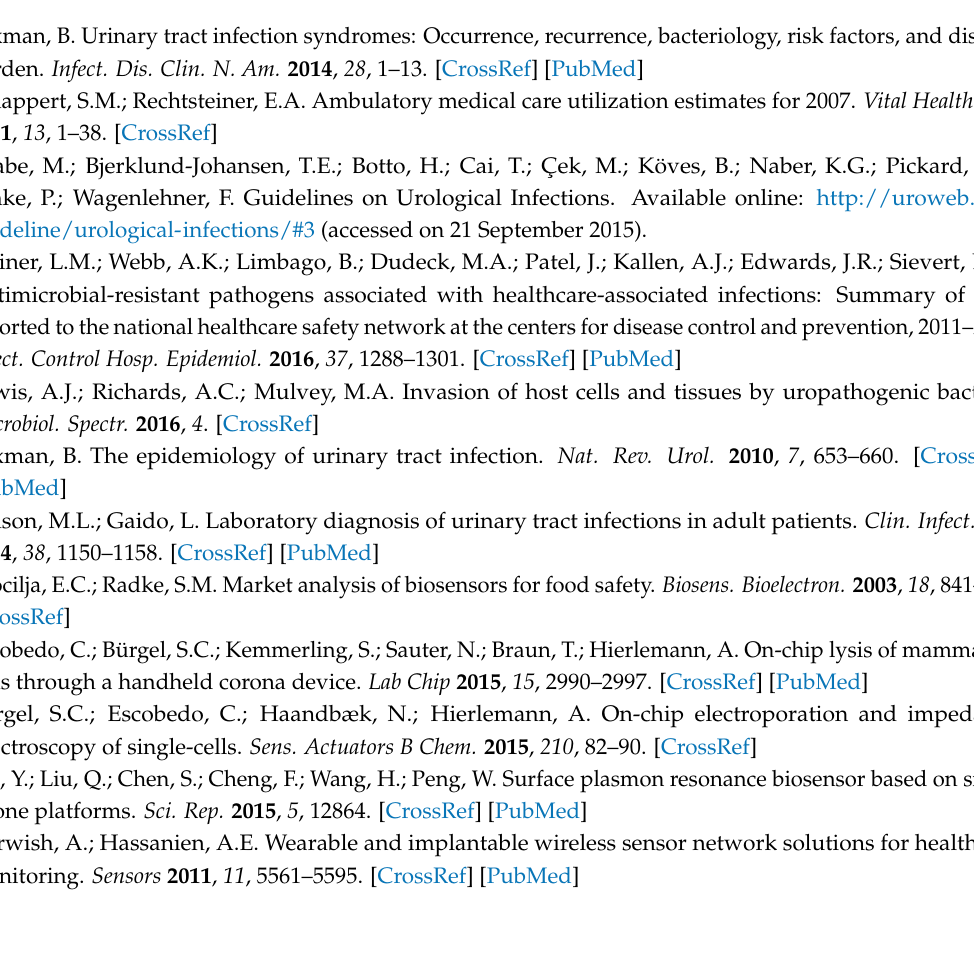
s1, Figure S1: Relative shift in SPR peak recorded for water from t = 0 min to t = 20 min, with 30-s interval between signal acquisition. Figure S2: Relative shift in SPR peak recorded for PBS solution from t = 0 min to t = 20 min, with 30-s interval between signal acquisition. Figure S3: Relative shift in SPR peak recorded for bound streptavidin on the immobilized cysteamine/biotin complex on CSRG surface from t = 0 min to t = 20 min, with 1-min interval between signal